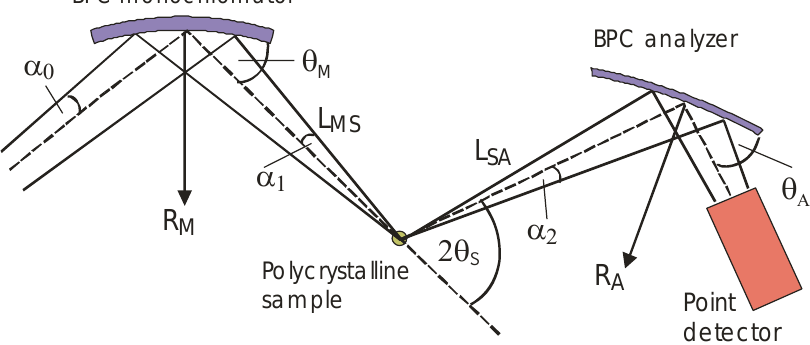
Figure 16. Schematic drawing of the three-axis diffractometer setting employing a BPC monochromator and analyzer (as used in the experiment, R M , R A - radii of curvature, θ M , θ A - Bragg angles) and operating at the neutron wavelength of λ = 0.162 nm.